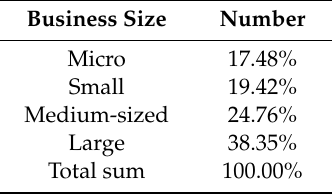
Table 3. Structure of the research sample according to